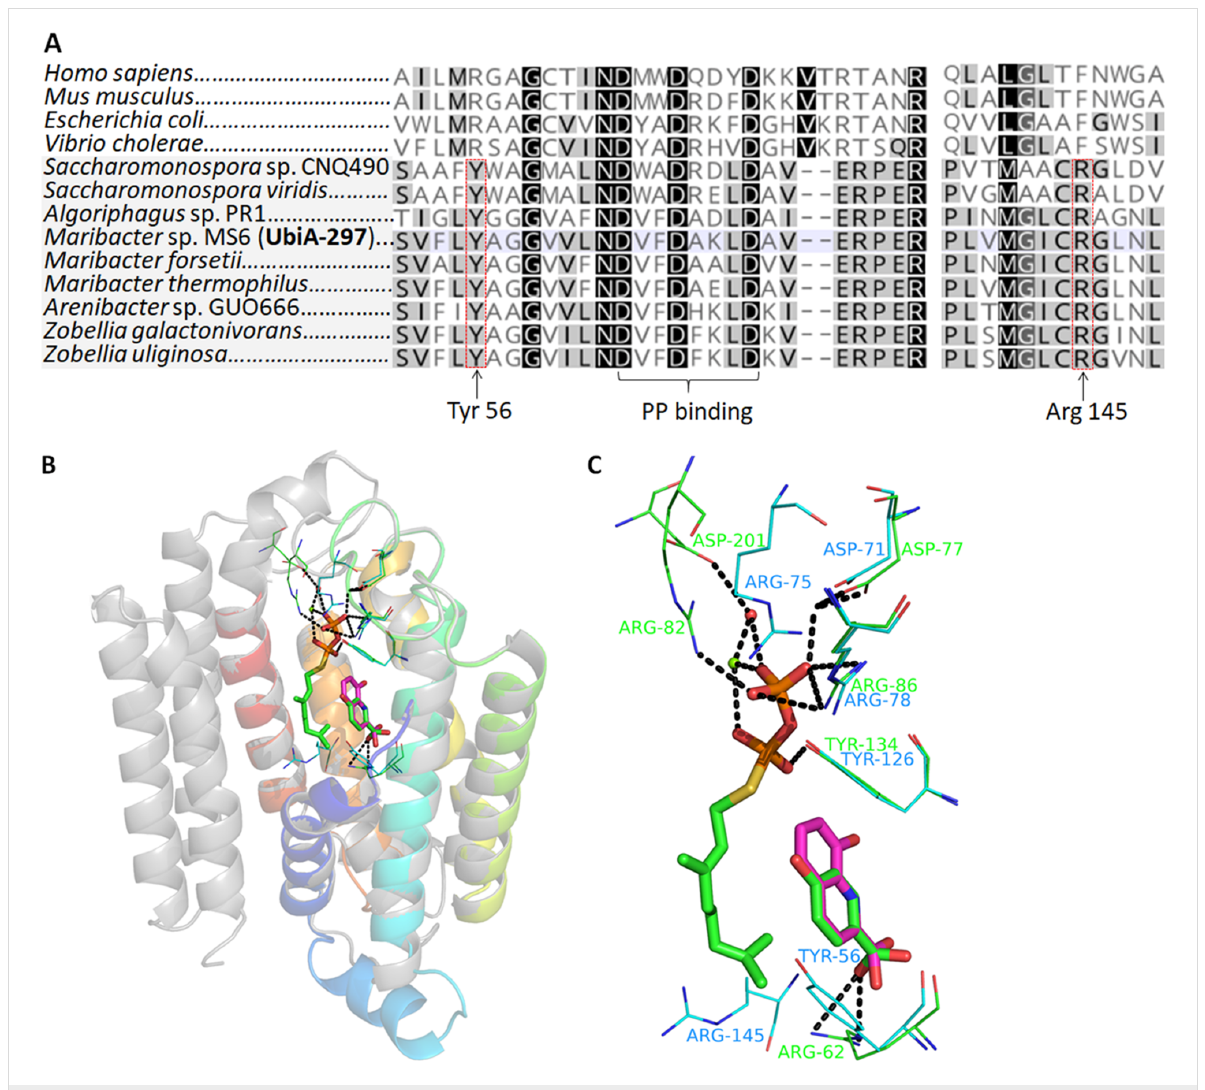
Figure 4: A) Amino acid alignment and binding residues of UbiA-297. G2-Ptases are illustrated in the grey box. B) Homology model of UbiA-297 (in color). Model is based on the substrate-bound structure of a UbiA homolog from Aeropyrum pernix sp. K1 (grey). C) The pyrophosphate and aromatic substrate binding sites of UbiA-297 model (shown in green) and template structure (shown in blue). 8-HQA (pink) is paired to 4-HBA (green) after energy